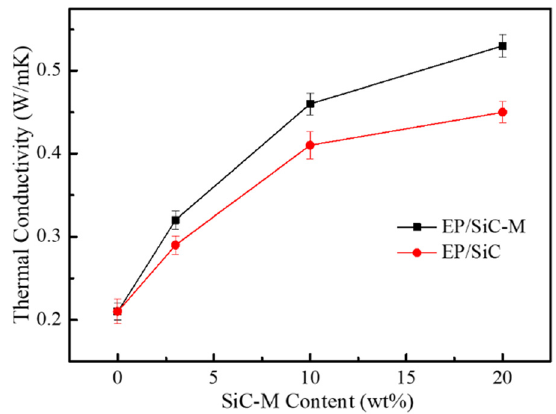
Figure 10: Thermal conductivity of EP and composites EP/SiC - M with di ff erent contents of SiC